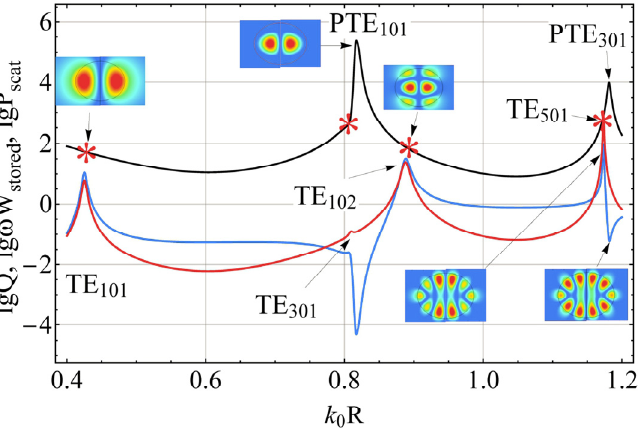
Figure 11. The dependence of logarithms of scattered power (blue), stored energy (red), and gener- alized quality factor Q = ω W stored /P scat (black) on the size parameter of nanoparticles simulated within Comsol Multiphysics. TE excitation (22), ξ = -9.915, ε = 50, a/b = 0.8 (oblate spheroid). The insets show the distribution of | E φ | corresponding to the maxima of stored energy or Q -factor. The asterisks on the black curve show the Q factor values of the usual modes.